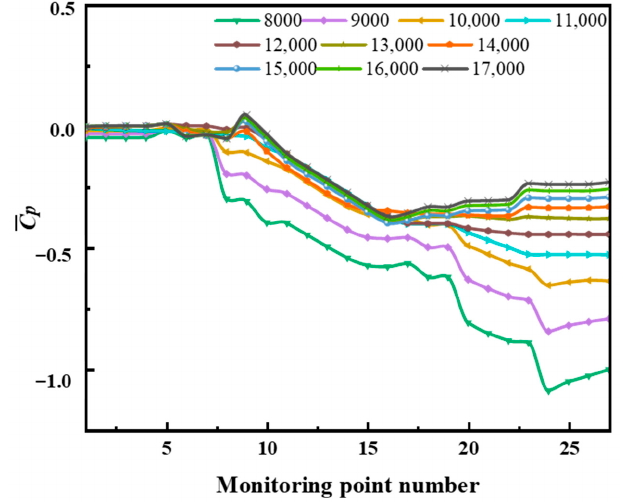
Figure 10. Time-averaged pressure coefficient of the first-stage liquid-sealing impeller under different rotating speeds. rotating speeds.